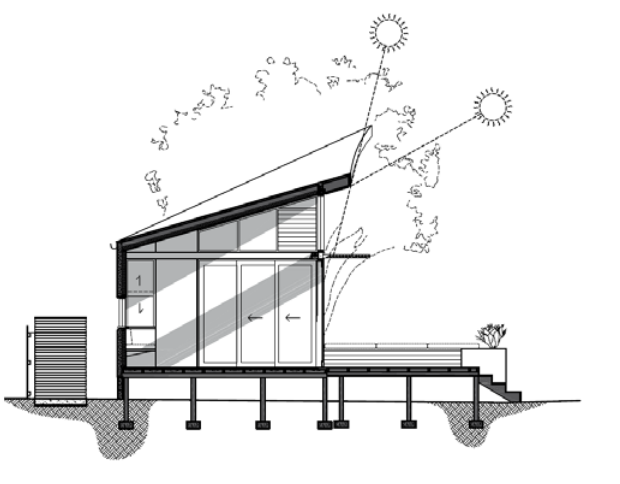
Figure 2: Daylight study for Brighton Compact (Callery & Bartak